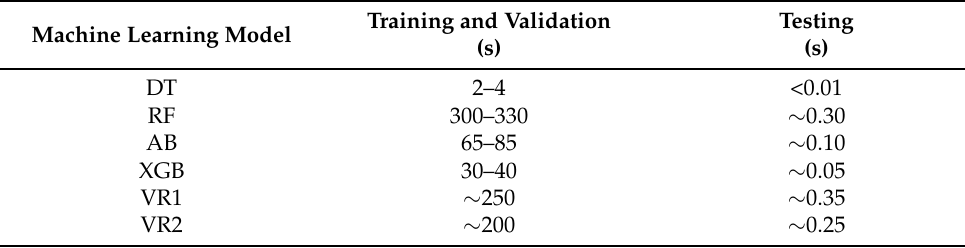
Table 4. Execution time in seconds of the VTEC models using NVIDIA Tesla P100 GPU with 16 GB